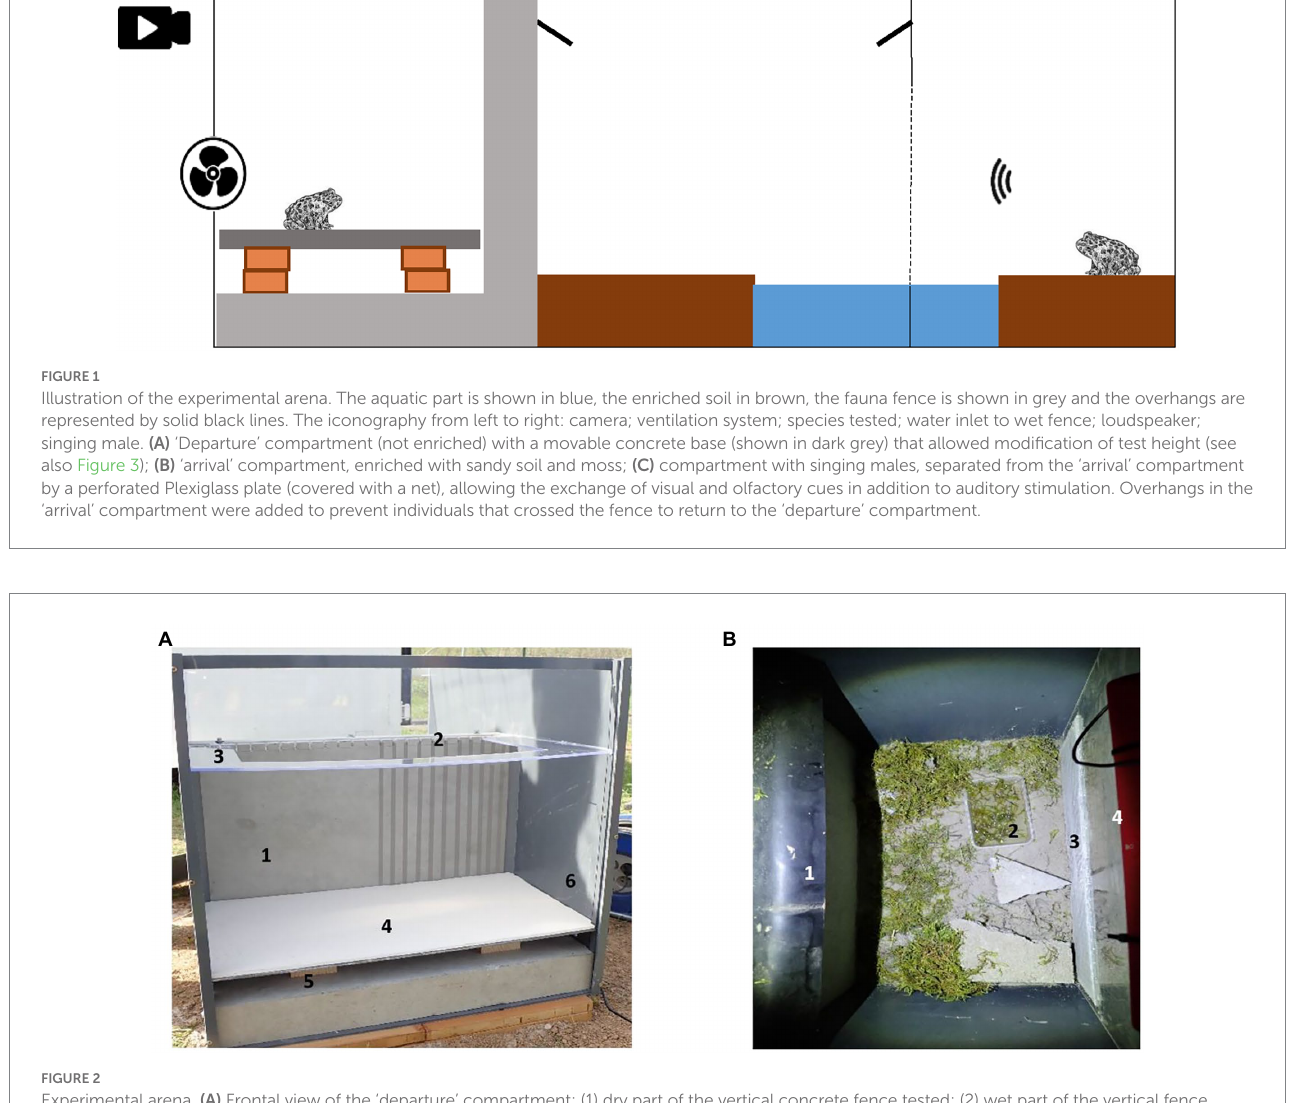
according to results of a previous study, in which a 10 cm overhang was sufficient to prevent the crossing of green toads and marsh frogs ( Pelophylax ridibundus ; Conan et al., 2022). The bent overhang for the metal fence was required to provide structural stability and the dimensions used were readily available commercially. To allow testing of different fence heights, the movable base of the departure